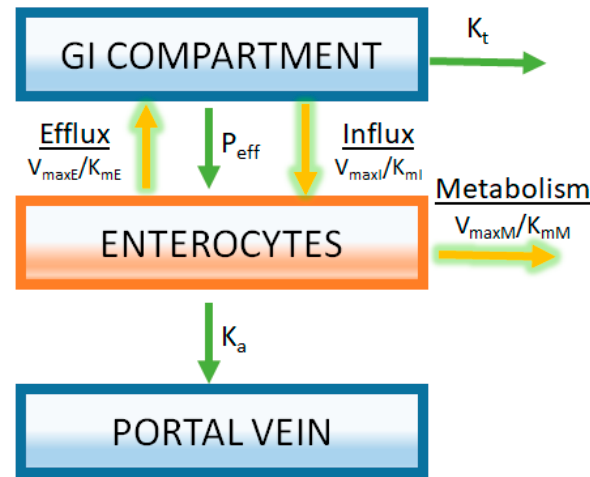
Figure 5. Modeling of transporters and intestinal metabolism is achieved by separately compartmentalizing the enterocytes. Rates of transport and metabolizing enzyme activity are described by Michaelis-Menten kinetics using parameters derived from in vitro enzyme activity assays ( V max E , V max I , and V max M are the maximum rate for efflux transporters, influx transporters, and metabolic enzymes respectively; K mE , K mI , and K mM are the Michaelis-Menten constants for efflux transporters, influx transporters, and metabolic enzymes, respectively). In this example, it is assumed that substrate concentrations are far below saturation (Equation (7)).